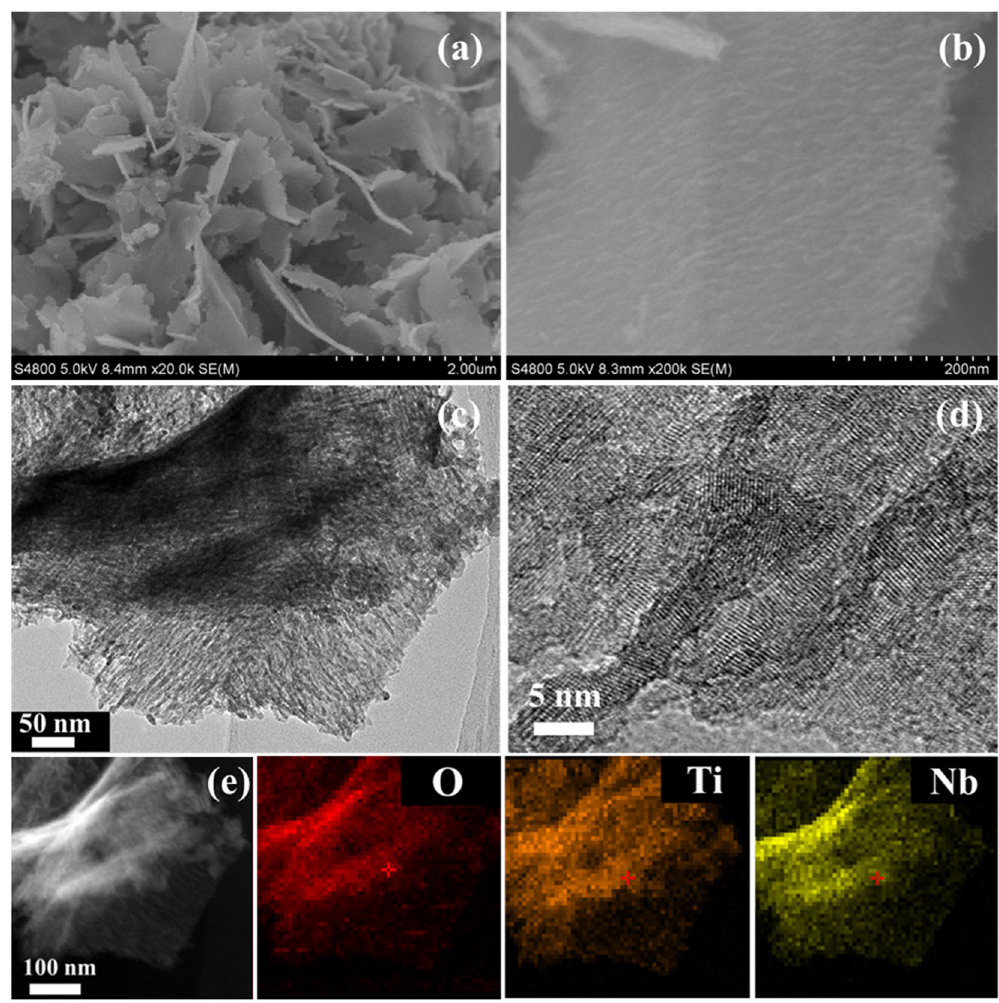
Figure 1. ( a , b ) SEM image, ( c , d ) TEM images and ( e ) STEM image and elemental mappings of TiO 2 @Nb 2 O 5 was larger than that of pure Nb 2 O 5 nanosheets. The surface difference of TiO 2 @Nb 2 O 5 composites and Nb 2 O 5 nanosheets indicates that TiO 2 nanoparticles were embedded on Nb 2 O 5 nanosheets. Apart from the uniform TiO 2 @Nb 2 O 5 composites, single TiO 2 nanoparticles are not observed. TEM images in Fig. 1c shows that the whole surface of Nb 2 O 5 nanosheets was covered with TiO 2 nanoparticles, and further confirms that TiO 2 @Nb 2 O 5 heterogeneous structure can be formed. In a HRTEM image of TiO 2 @Nb 2 O 5 composites in Fig. 1d, it can be found that the size of TiO 2 nanoparticles was about 5 nm, which is smaller than that of pure TiO 2 nanoparticles (Figure S1f). To investigate the chemical composition of the TiO 2 @Nb 2 O 5 composites, EDX analysis was carried out and the result is depicted in Figure S3. Strong O, Ti and Nb signals can be observed and ICP-OES results (Table S1) showed that the atomic ratio of Nb to Ti was 0.44. At the same time, STEM image and the correspond- ing elemental mappings O, Ti and Nb were performed to investigate the distribution of TiO 2 nanoparticles in the Nb 2 O 5 nanosheets. As shown in Fig. 1e, TiO 2 nanoparticles were evenly embedded on the surface of Nb 2 O 5 nanosheets. AFM measurement was performanced to determine the thicknesses of Nb 2 O 5 nanosheets and TiO 2 @Nb 2 O 5 composites. As shown in Fig. 2, the thicknesses of Nb 2 O 5 nanosheets and TiO 2 @Nb 2 O 5 composites were about 4.5 and 16 nm, respectively, further indicating that the size of TiO 2 nanoparticles was about 6 nm. On the other hand, it can be clearly found that the surface of Nb 2 O 5 nanosheets appeared smooth, while the surface of TiO 2 @Nb 2 O 5 composites was rough. The AFM results were in good agreement with SEM and TEM results. Figure 3 shows the XRD patterns of TiO 2 @Nb 2 O 5 composites. The diffraction peaks can be indexed to the mixed of monoclinic Nb 2 O 5 (JCPDS 43-1042) and anatase TiO 2 (JCPDS 21-1272). Furthermore, Raman spectra of TiO 2 nanoparticles, Nb 2 O 5 nanosheets and TiO 2 @Nb 2 O 5 composites were also recorded and the results are presented in Figure S2. Raman spectrum of TiO 2 @Nb 2 O 5 composites exhibited the characteristic peaks of anatase TiO 2 and weak peaks of Nb 2 O 5 , which is consistent with the XRD result.